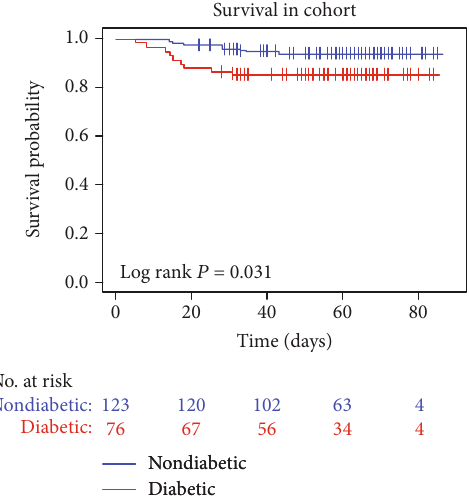
Figure 1: Survival curve in patients with COVID-19 pneumonia with and without